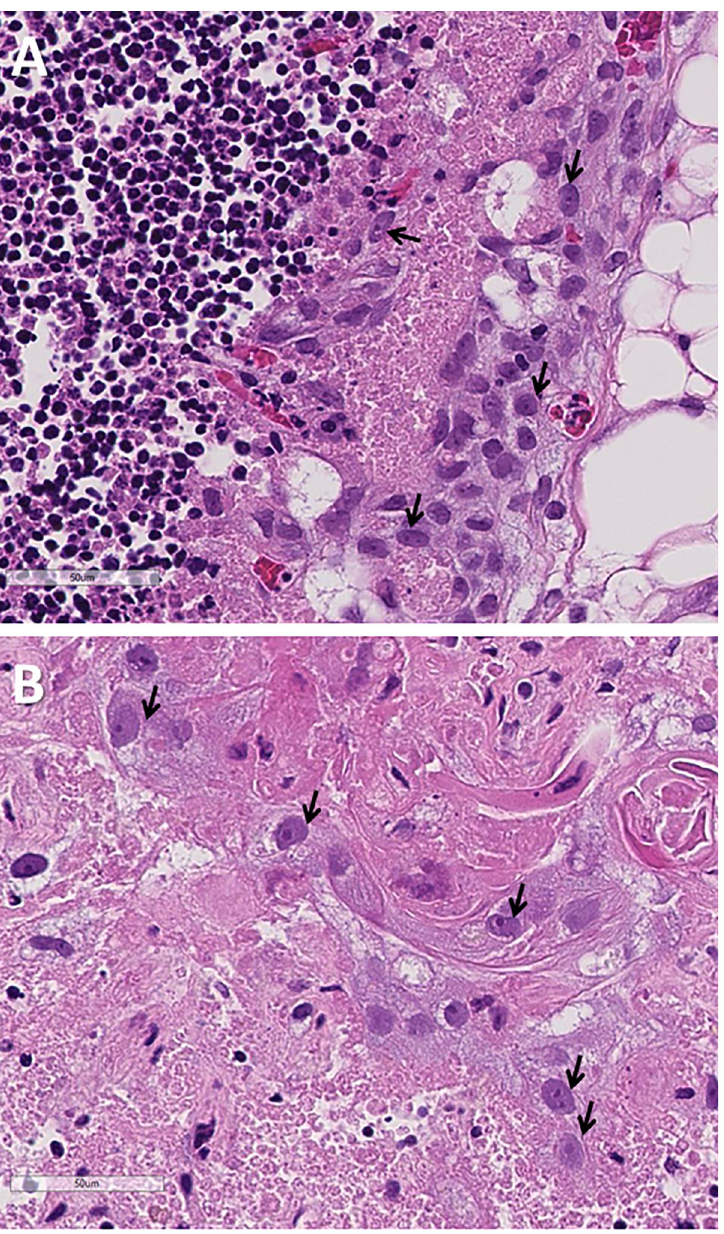
Fig 7. Assessing intact nuclei in thymus slices. Examples of intact thymic epithelial cell nuclei (arrows) are shown in the subcapsular cortex on day 9 (panel A) and in the medulla on day 21 (panel B). Hematoxylin and eosin stain; bar represents 50 μ